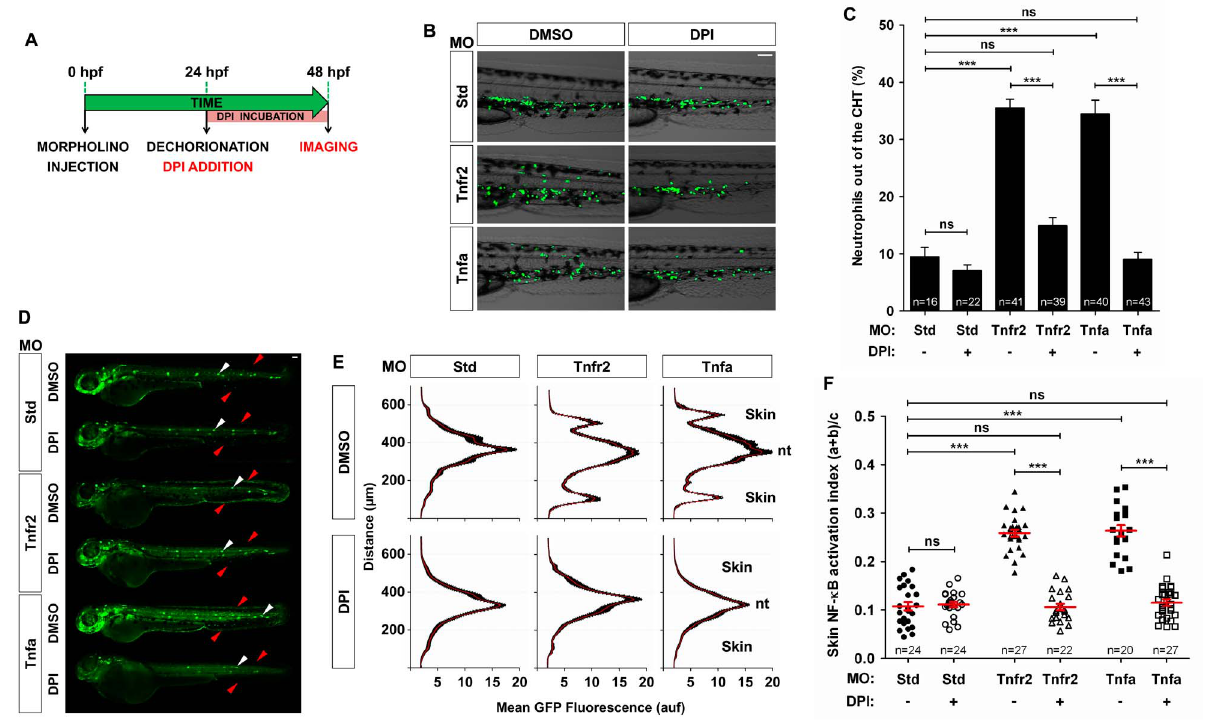
Figure 6. Pharmacological inhibition of Duox1 prevents skin inflammation in Tnfa- and Tnfr2-deficient zebrafish. Zebrafish one-cell mpx:eGFP (B, C) and NF- k B:eGFP (D–F) embryos were injected with standard control (Std), Tnfr2, or Tnfa MOs. (A) Scheme showing the experimental procedure: embryos were dechorionated at 24 hpf and treated by immersion in 100 m M DPI or vehicle alone (DMSO) for 24 h. (B, C) Representative images of bright field and green channels of the morphants at 48 hpf showing the differences in the neutrophils distribution (B) and quantification of neutrophil mobilization from the CHT to the skin in the indicated number of larvae per group from three different experiments (C). (D–F) Quantification of NF- k B activation in the skin of Tnfr2- and Tnfa-deficient larvae at 72 hpf. (E) Fluorescence intensity was measured for all the groups in the area indicated, as explained in the legend to Figure 1 (15 larvae per treatment from 3 different experiments). The skin and the notochord (nt) have been labeled to facilitate the larval orientation. Note the activation of NF- k B in the skin (red arrowheads) of Tnfr2-deficient larvae. Note the strong expression of NF- k B in neuromasts (white arrowheads). (F) Skin NF- k B activation index was defined as the fluorescence in the skin (a + b) relative to the total fluorescence of the whole larvae (c). Each dot represents the skin NF- k B activation index per single larva. The mean 6 S.E.M. of the skin NF- k B activation index for each group of larvae is also shown. Scale bars, 100 m m. ns, not significant. *** p , 0.001.